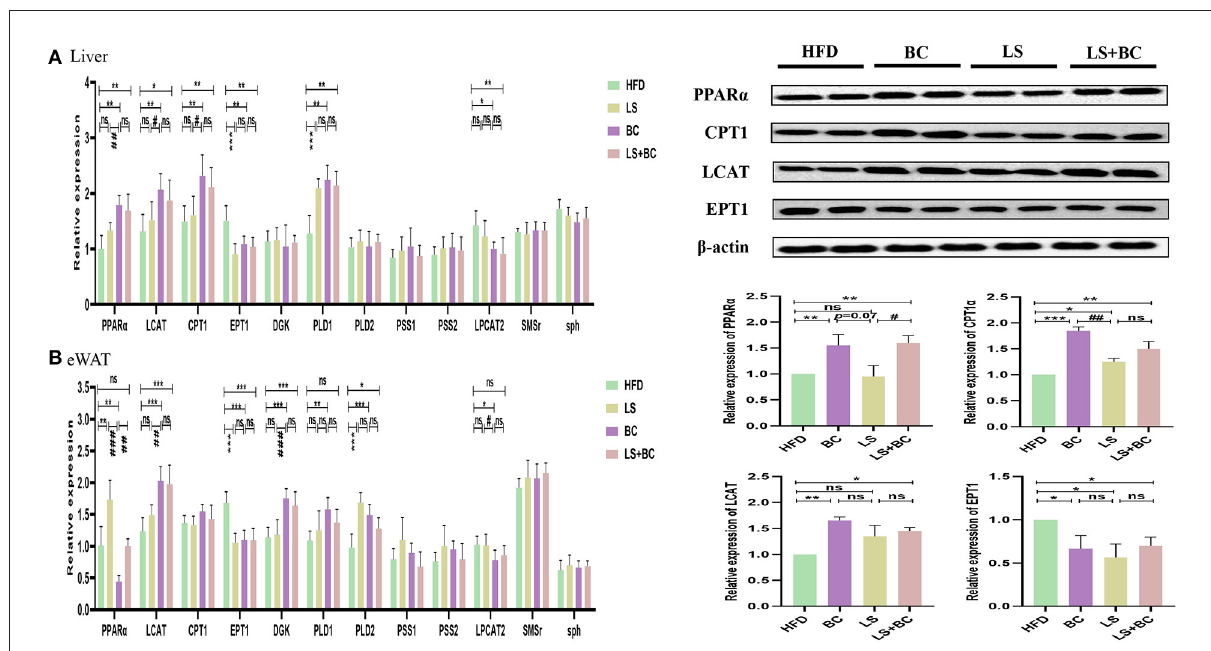
FIGURE9 Effect of BCPs treatment on hepatic and eWAT gene expression linked to glycerophospholipid metabolism and sphingolipid metabolism in HFD-induced obese rats. The glycerophospholipid metabolism and sphingolipid metabolism pathway related genes were measured and β -actin gene was applied as a reference. (A) the mRNA expression in the liver; (B) the mRNA expression in the eWAT. The Values are means ± SEMs. * p < 0.05, ** p < 0.01, and *** p < 0.001 compared with HFD group, # p < 0.05, ## p < 0.01, ### p < 0.001 compared with BC